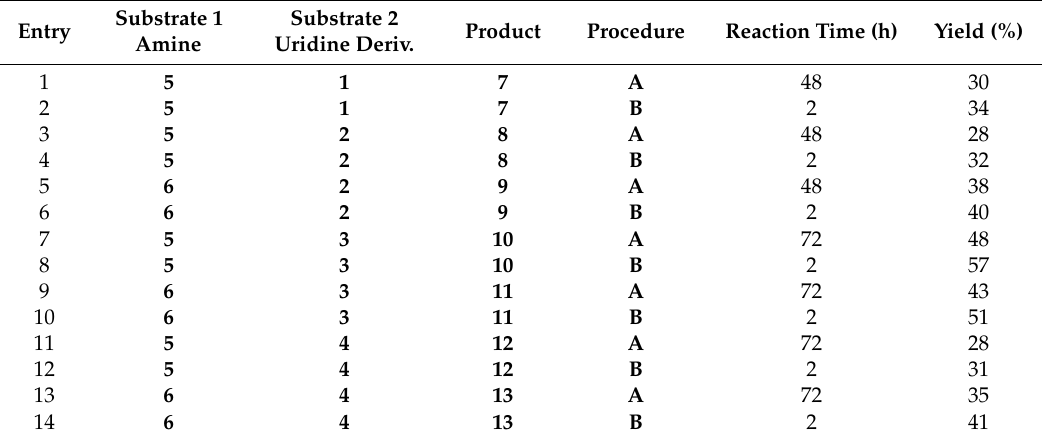
Table 1. Yields of glycoconjugates 7 – 13 .